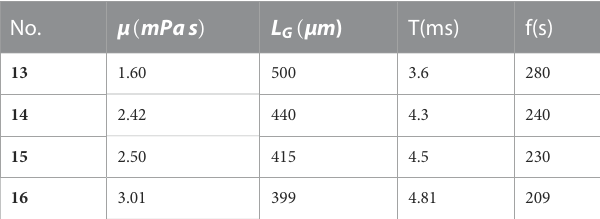
TABLE 7 Generation features of different viscosity.